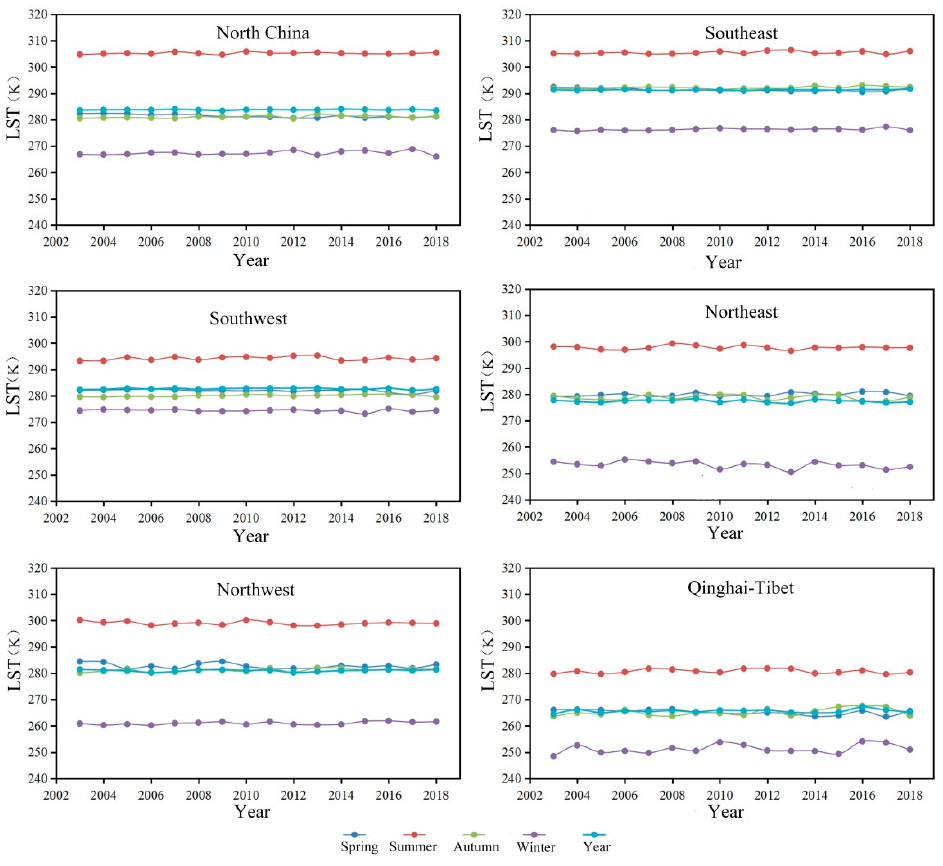
Figure 9. Variations in annual average LST from 2003 to 2018.